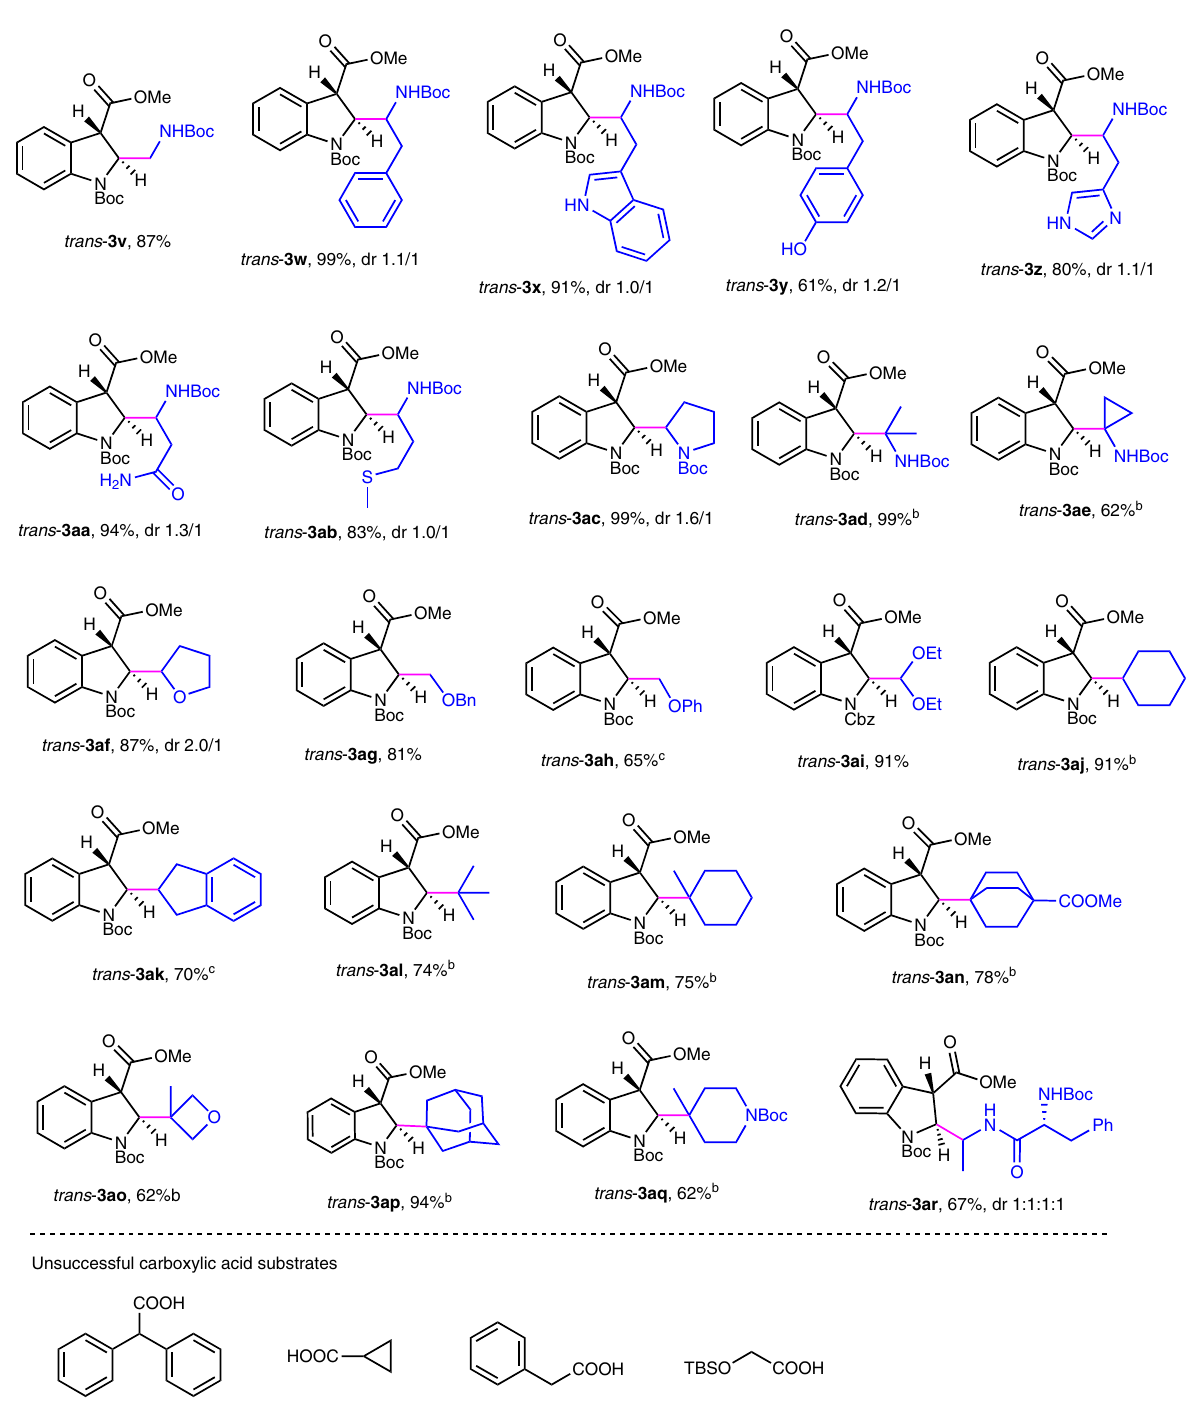
a For all cases, product is a racemic mixture. Yields refer isolated yields after column chromatography. dr was determined by 1 H NMR of crude mixtures. b carboxylic acid (0.40 mmol, 2.0 equiv) and two 40W Kessil blue LED lamps were used. c carboxylic acid (0.30 mmol, 2.0 equiv) and two 40W Kessil blue LED lamps were used. Fig. 3 Scope of carboxylic acids. Unless speci fi ed, see the general procedure in Supplementary Methods Section 1.5 for the experimental